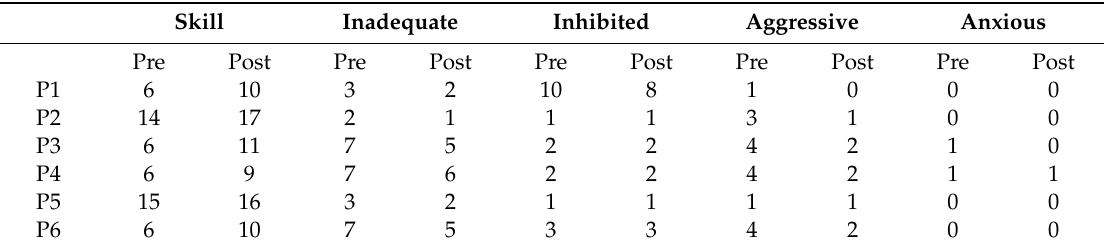
Table 6. Pre-test / post-test results of the social skills’ distribution in the social skills test. Skill Inadequate Inhibited